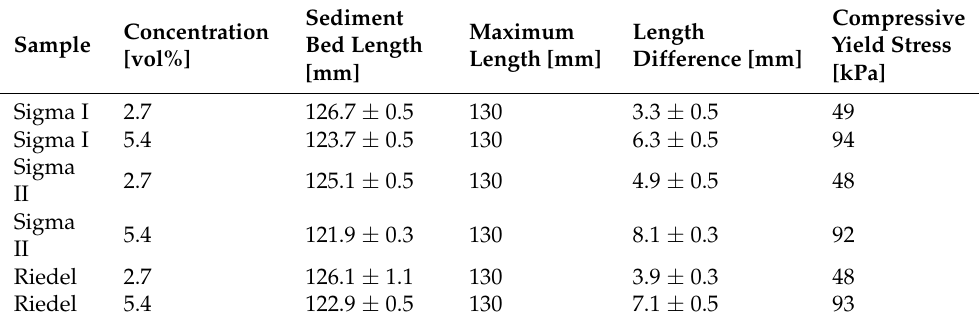
Table 5. Estimation of compressive yield stress-based data presented